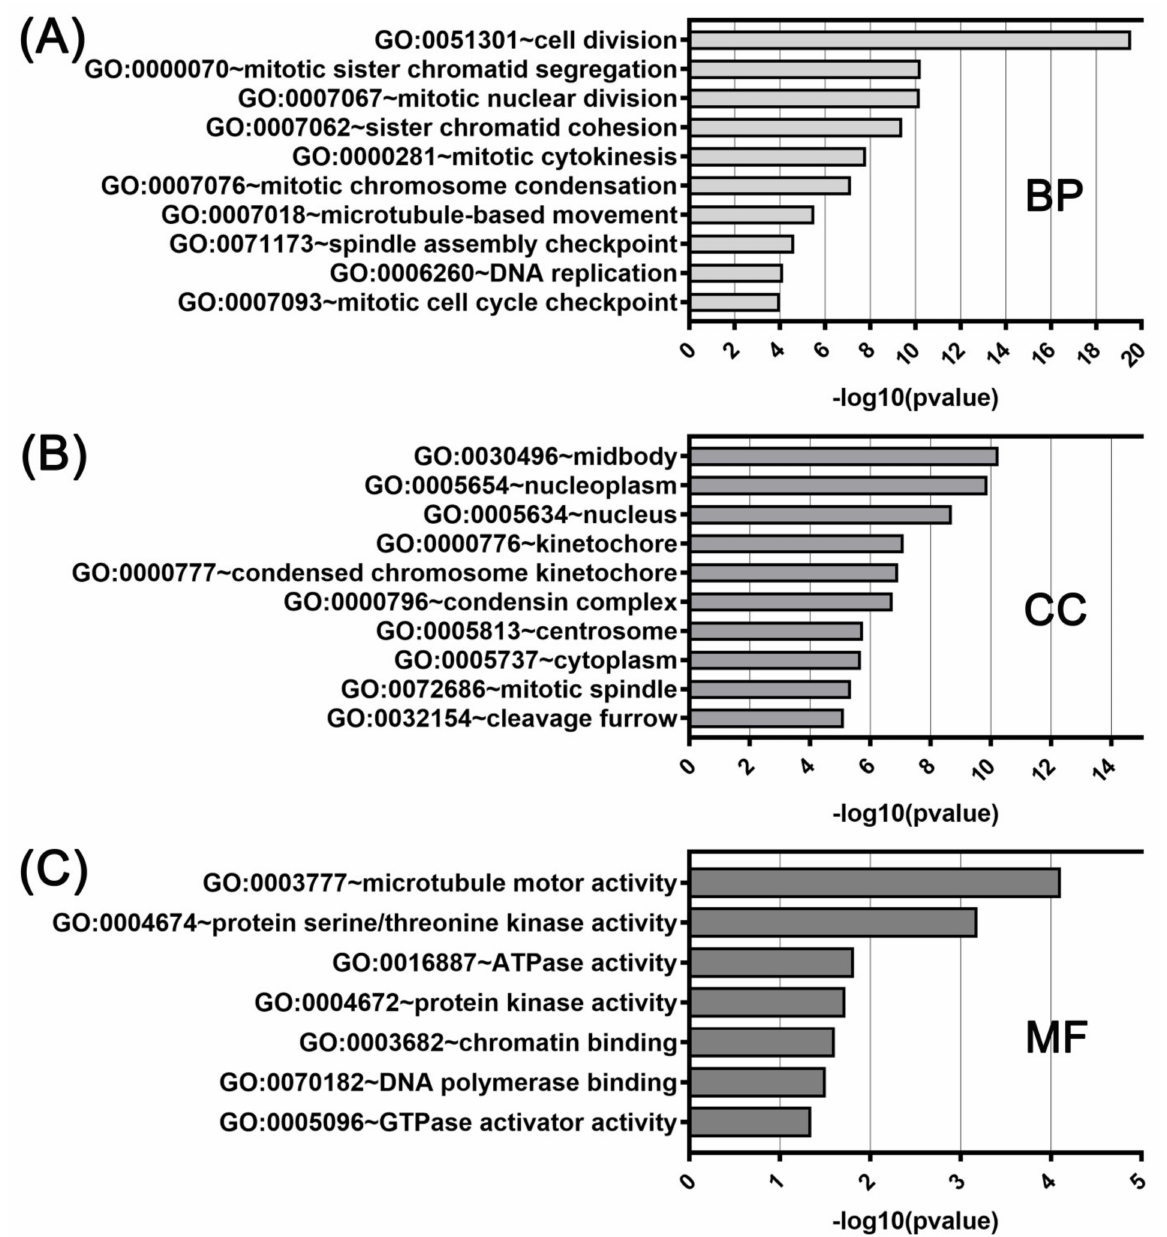
Figure 6. DAVID functional GO analysis of biological processes ( A ; BP), cellular components ( B ; CC), and molecular functions ( C ; MF). The top 10 GO terms for BP, CC and 7 GO terms for MF are presented for genes co-upregulated with KIF11 . The p value was calculated and sorted with − log10( p